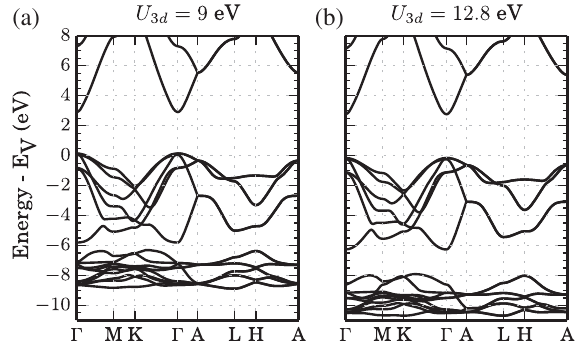
FIG. 5. Effect of the zinc on-site Coulomb repulsion U 3 occupied 3 d bands. An ad hoc value of U 3 compared against the converged value of 12.8 eV (b). Both cases use the converged values of U 2